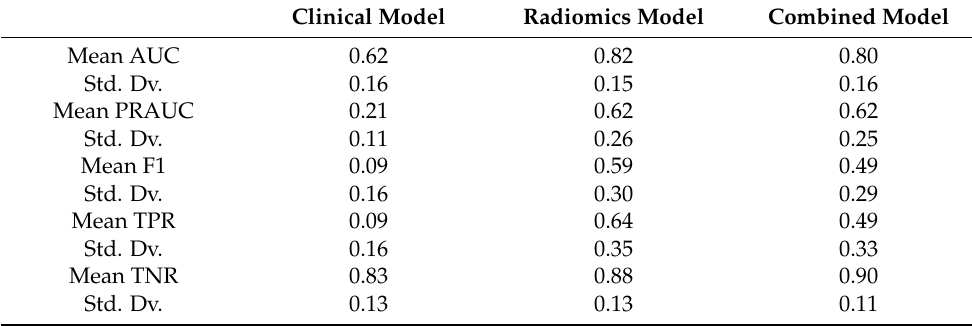
Figure 3. The average precision-recall ROC curves of the selected radiomics model, the clinical model, and the combined model with both radiomic and clinical features. The mean PRAUC was 0.21, 0.62, and 0.62 for the clinical model, the radiomics model, and the combined model, respectively. Table 4. ROC analysis results for comparing the selected radiomics model, the clinical model, and the combined model with both radiomic and clinical features on 1000-round stratified 3-fold cross- validations. AUC: Area under ROC curve; Std. Dv.: standard deviation; PRAUC: area under the precision-recall ROC curve; TPR: true positive rate; TNR: true negative